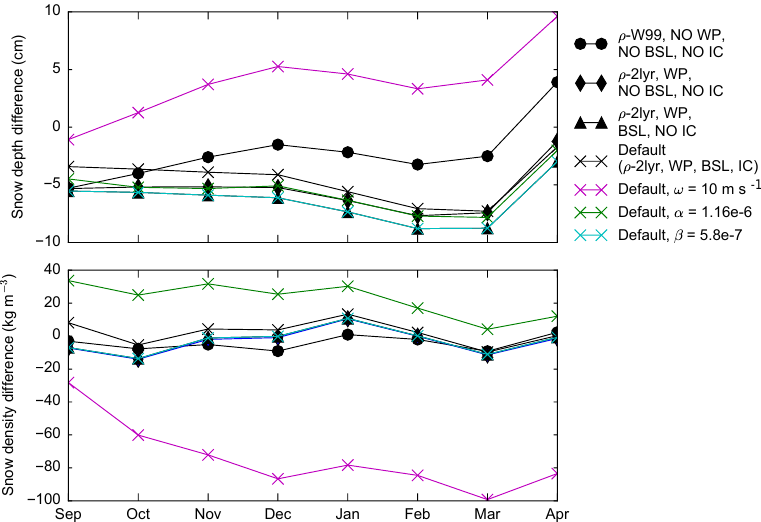
Figure 4. Differences between the mean (1980–1991) seasonal cycles in the drifting station data against various configurations of NESOSIM. The different symbols represent different levels of model sophistication – ρ -W99: climatological Warren snow density, ρ -2lyr: default prognostic two-layer snow density, WP: wind-packing parameterization, BSL: blowing snow loss parameterization, IC: initial conditions. NO indicates that the parameterization/initial conditions have been turned off. The different colors then represent a doubling of individual model parameters, with all other settings fixed to the default settings (see Table 1). The black crosses and line represent the default/ERA-I results (as shown in Fig.